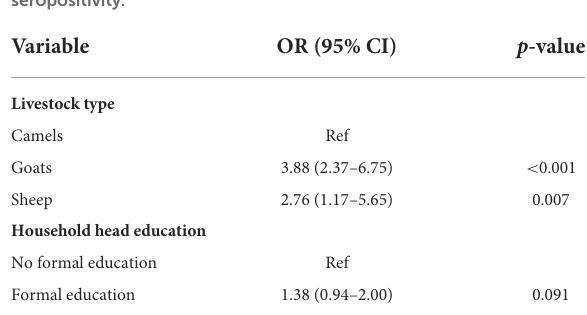
TABLE 4 Animal-level factors associated with brucellosis